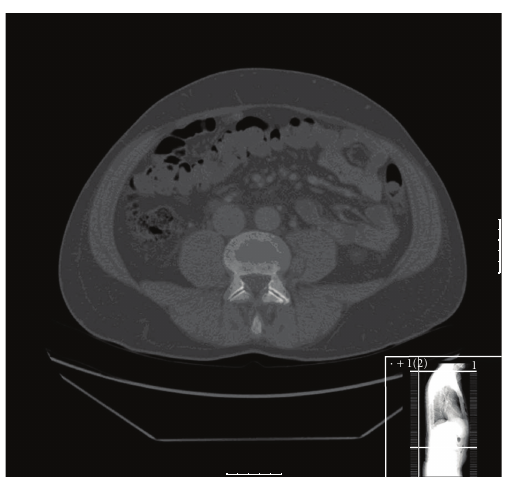
Figure 5: The CT image through L5 shows no significant abnormal- ity on bone windows in contrast to the MRI scan at the equivalent